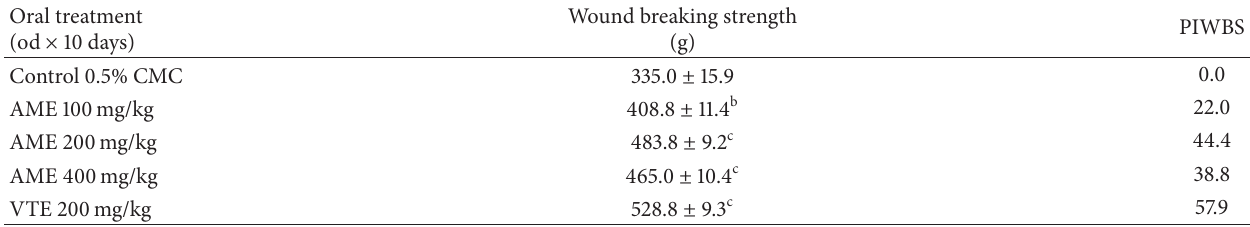
Table 1: Effect of graded doses of AME on wound breaking strength in incision